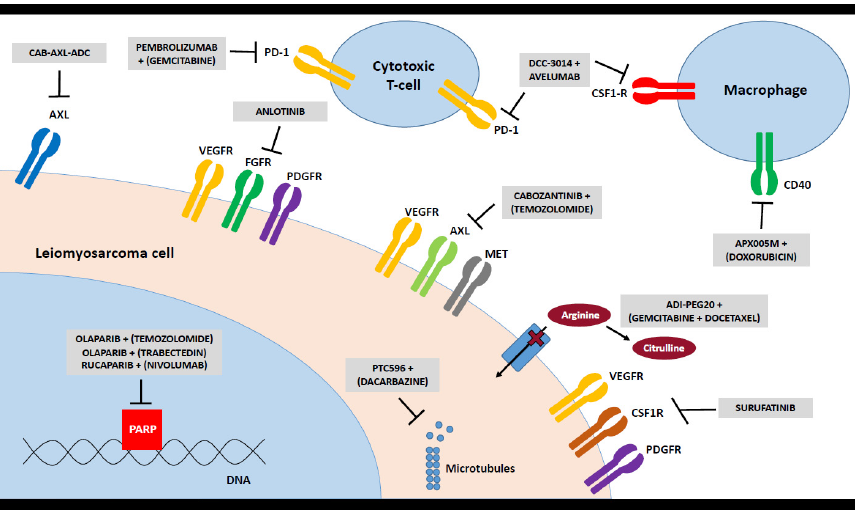
Figure 1. New possible treatment strategies and their mode of action for patients with LMS.